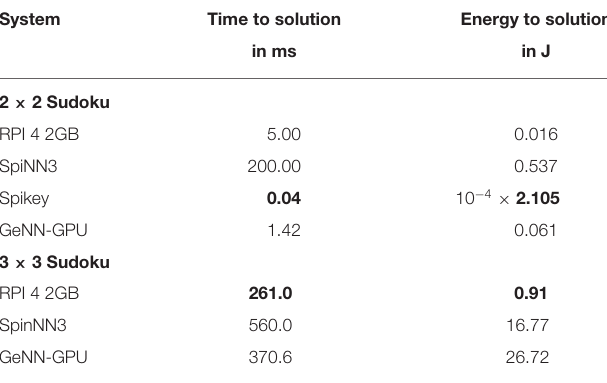
TABLE 7 | Comparing Sudoku solving on a Raspberry Pi 4 using an algorithmic approach with SNN solvers.